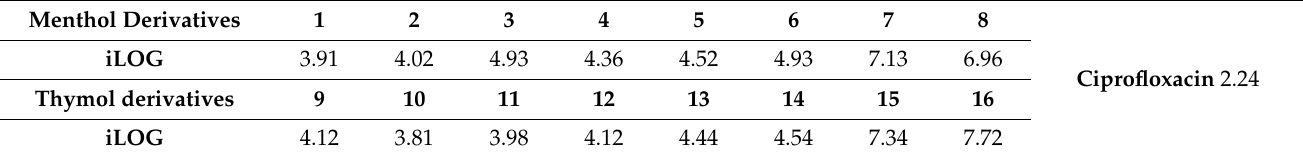
Table 1. Lipophilicity calculation for designed